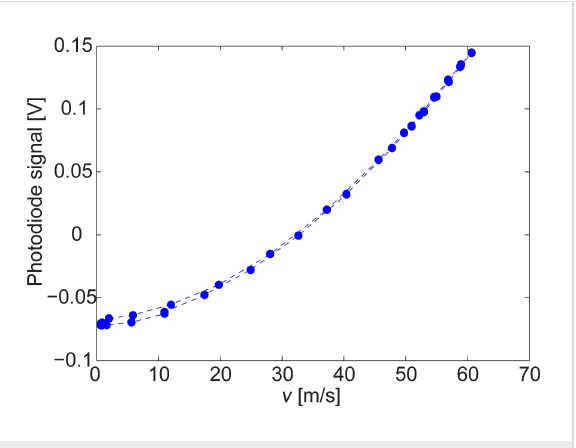
Figure 5: Cantilever deflection of NCHV under fluid flow from the microchannel measured at the free end of the cantilever.